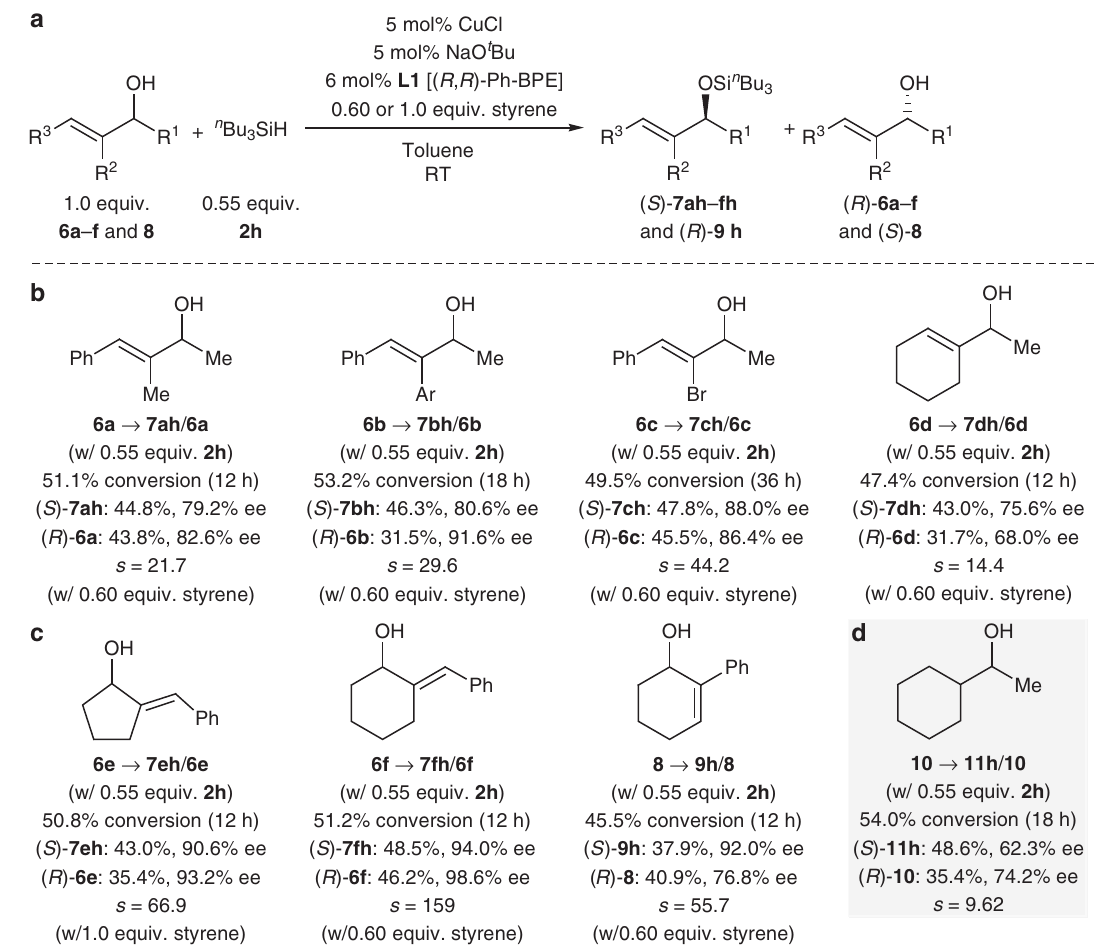
Figure 4 | Kinetic resolution of representative allylic alcohols and an example of an aliphatic secondary alcohol. ( a ) General equation. ( b ) Selected allylic alcohols (Ar ¼ 4-anisyl). ( c ) Cyclic systems with exo- and endocyclic double bonds. ( d )